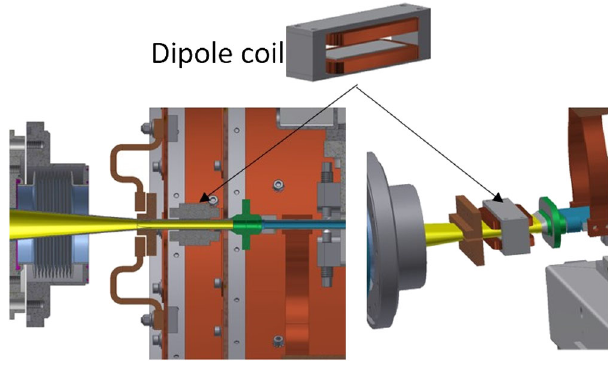
FIG. 6. Dipole coils installed upstream and downstream of the undulator magnet inside the cryostat that can be used to compensate the second field